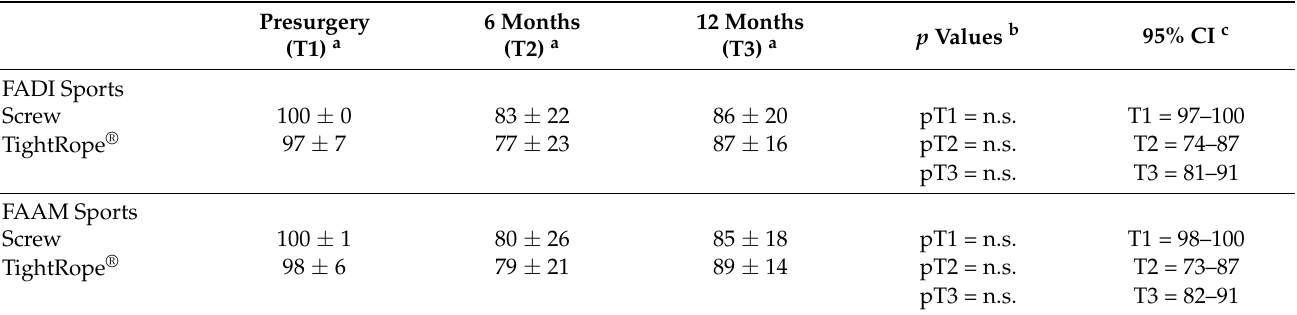
Table 3. Foot and Ankle Disability Index (FADI) a Sports Module.